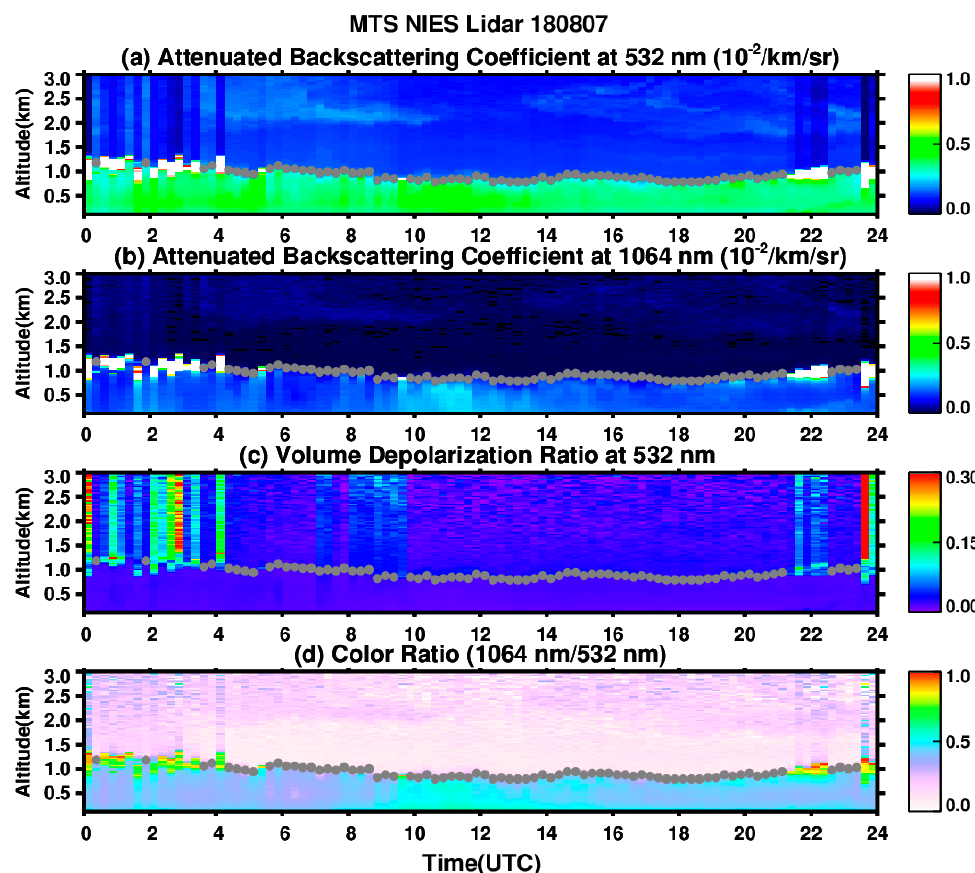
Figure3. ( a ) Attenuated backscatter coefficient at 532 nm, ( b ) attenuated backscatter coefficient at 1064 nm, ( c ) volume depolarization ratio at 532 nm, and ( d ) color ratio (1064 nm/532 nm) observed from AD − Net ground-based lidar on 7 August 2018. The gray solid circle indicates AD − Net lidar BLH.